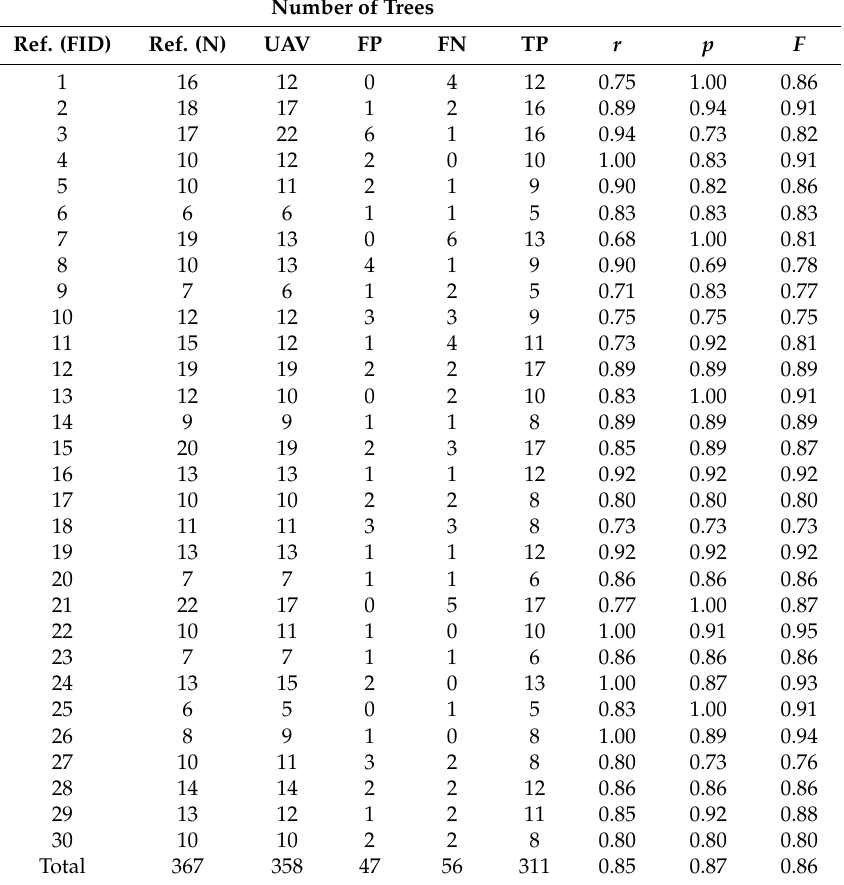
Table 3. Accuracy assessment results of UAV-based individual tree detection based on False Positive (FP), False Negative (FN), True Positive (TP), recall ( r ), precision ( p ) and F -score ( F ) statistics parameters; where, Ref. (N) is the reference number of trees per test plot .